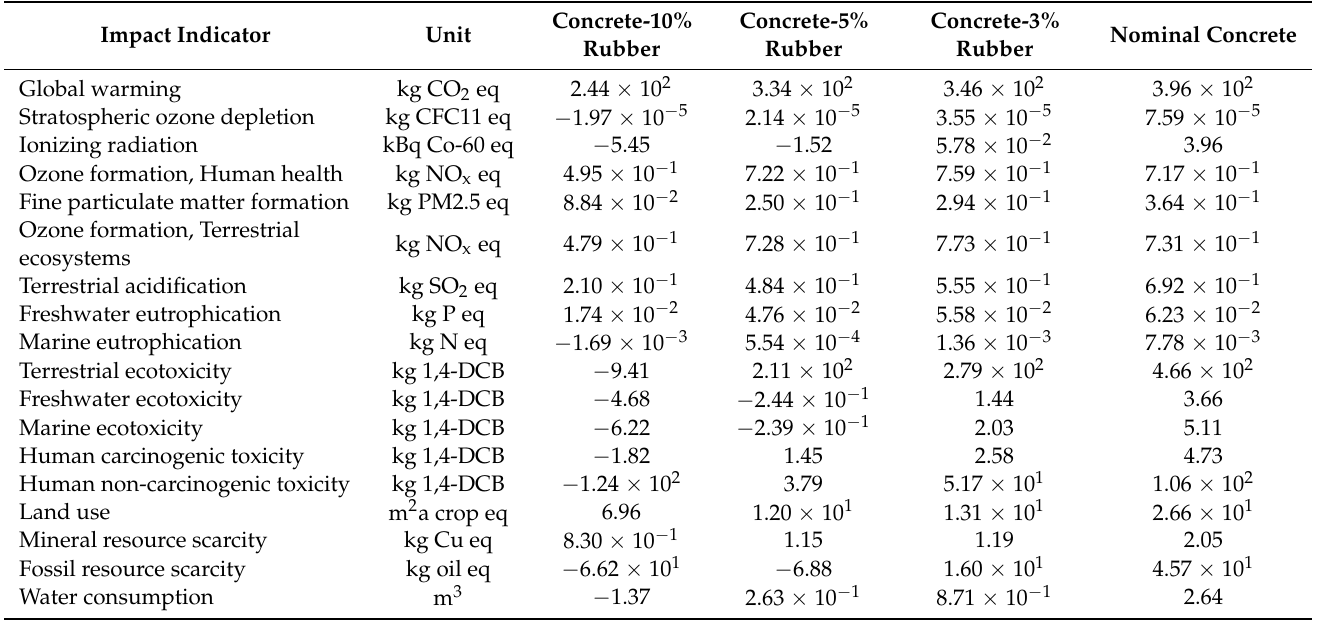
Table 8. LCA results for recycling rubber from tires used in 1 m 3 of